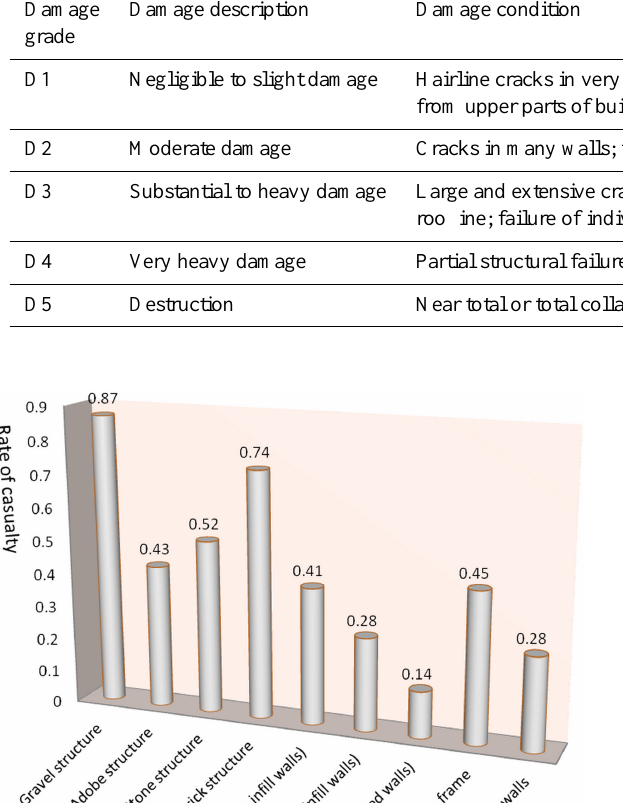
Table 1. Damage index and classification of damage to masonry buildings (EMS98). Damage